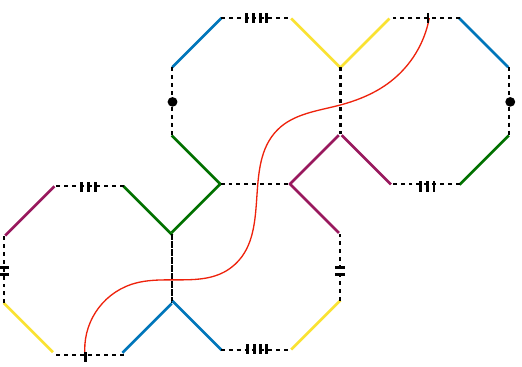
Figure 17 . Our construction with four boundary regions using four copies. Because so few gluings need to be performed the requirement that only copies and their CPT conjugate be glued automat- ically determines all of the identifications. Performing the gluing of tab 1 we can once again rotate the two boundaries and perform the remaining identifications to form a torus with four